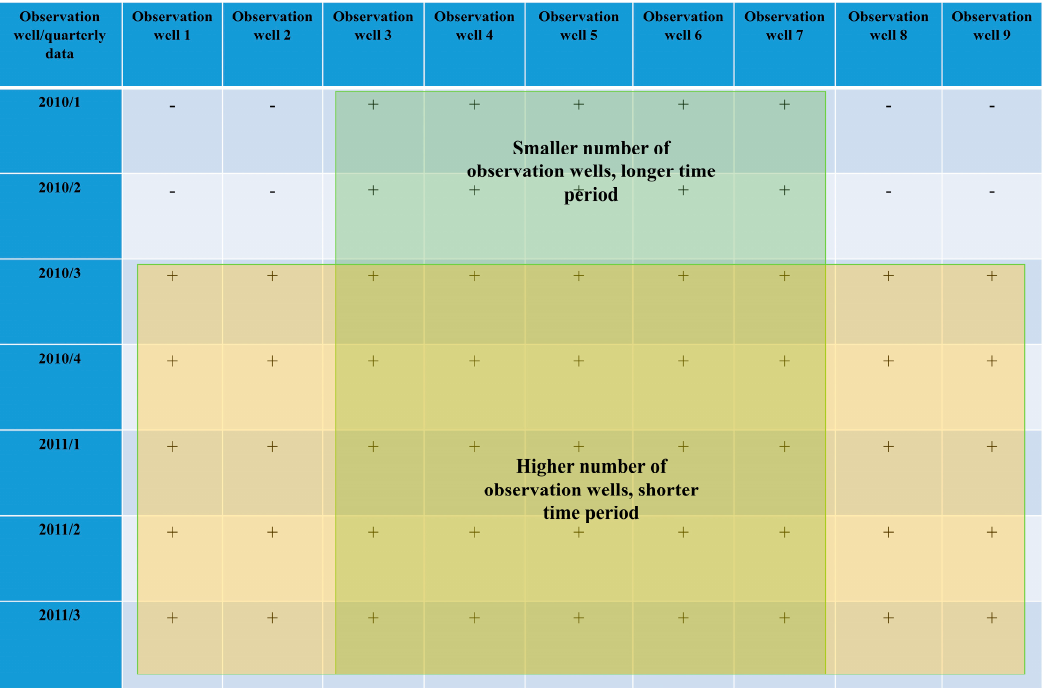
Figure 5. Illustration of possible choices when doing spatial data aggregation.